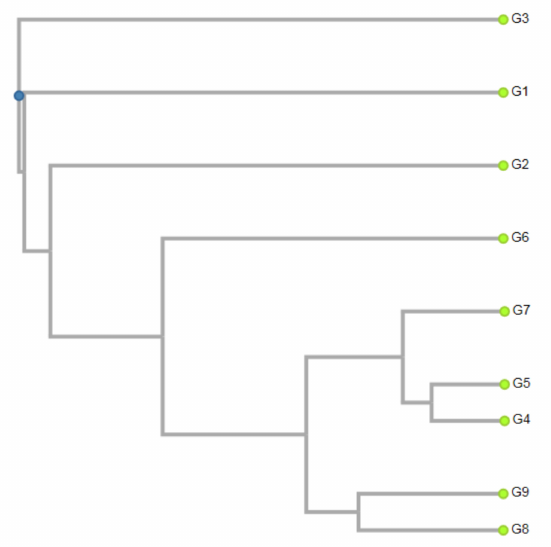
Figure 4. Dendrogram constructed by using unweighted pair group method using arithmetic averages (UPGMA)clusteranalysisof9genotypesof Ginkgobiloba onmiRNAmarkersgb-miR482_F / gb-miR482_R. G1—Nov á Ves nad Žitavou, G2—Topol’ˇcianky, G3—Luˇcenec, G4—Vel’k ý Blh, G5—Rimavsk á